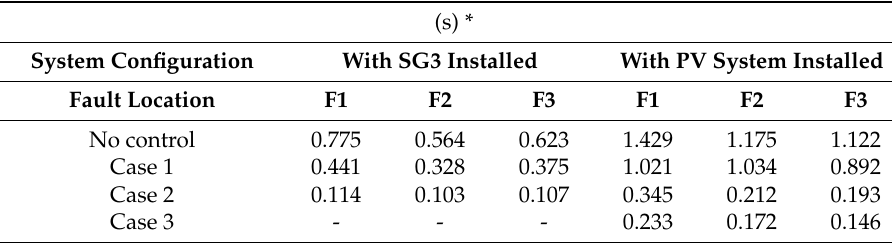
Table 5. Integrated value of absolute value of ∆ W total